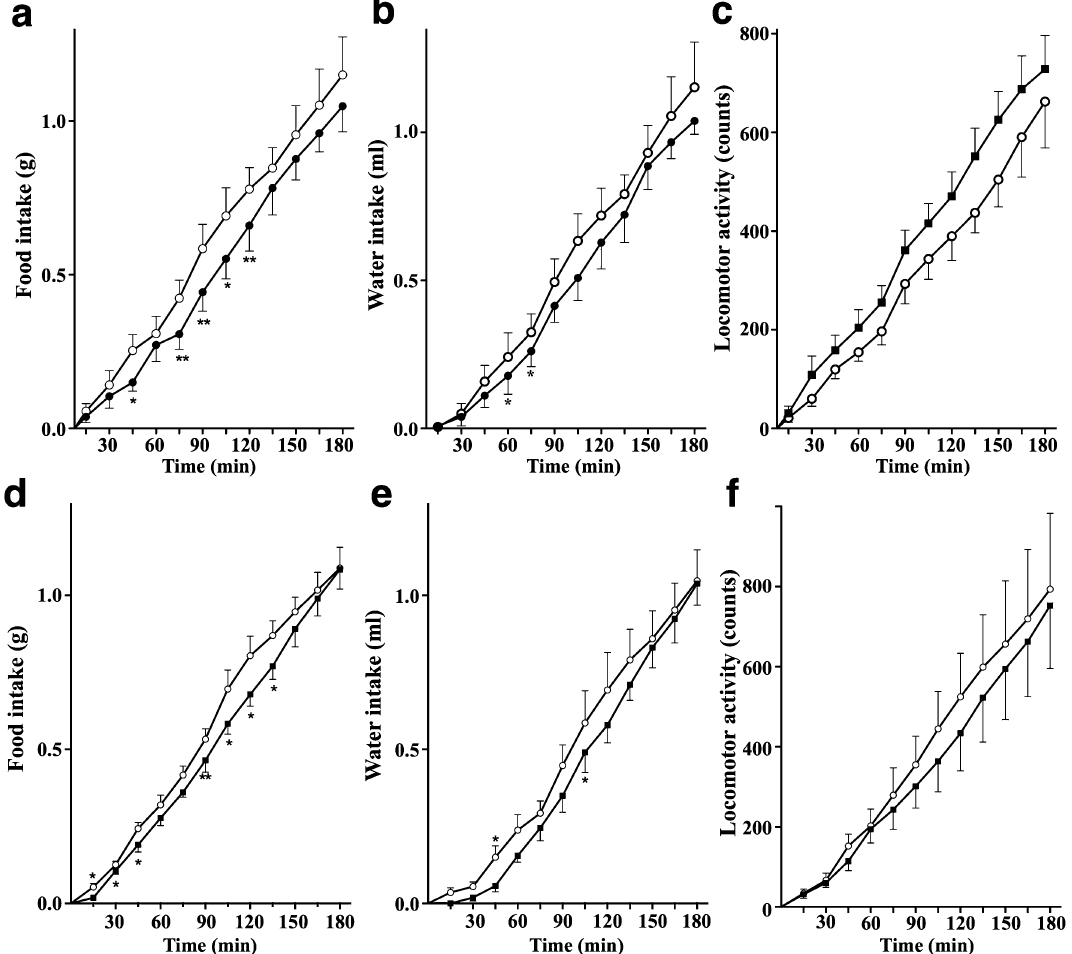
Figure 7. Effects of SBSN_HUMAN[279–295] on feeding, drinking and locomotor behaviors in mice. ( a – f ) Synthetic SBSN_HUMAN[279–295] was intraperitoneally injected to ad libitum watered and fed mice approximately 30 min before the onset of the dark phase, and cumulative food intake ( a , d ), water intake ( b , e ) and spontaneous locomotor activities ( c , f ) were monitored throughout the entire dark phase of the diurnal cycle. Cumulative food and water intake are expressed in grams and mL, respectively, and physical activity is represented by infrared beam interruption counts for non-treated mice (open circles), and for mice treated with 10 pmol/mouse ( a – c ) or with 100 pmol/mouse ( d – f ) SBSN_HUMAN[279–295] (closed circle) during the initial 180 min period. * p < 0.05, ** p < 0.01 compared with control animals. Data are expressed as the mean ± S.E.M. ( n = 6–7 mice per